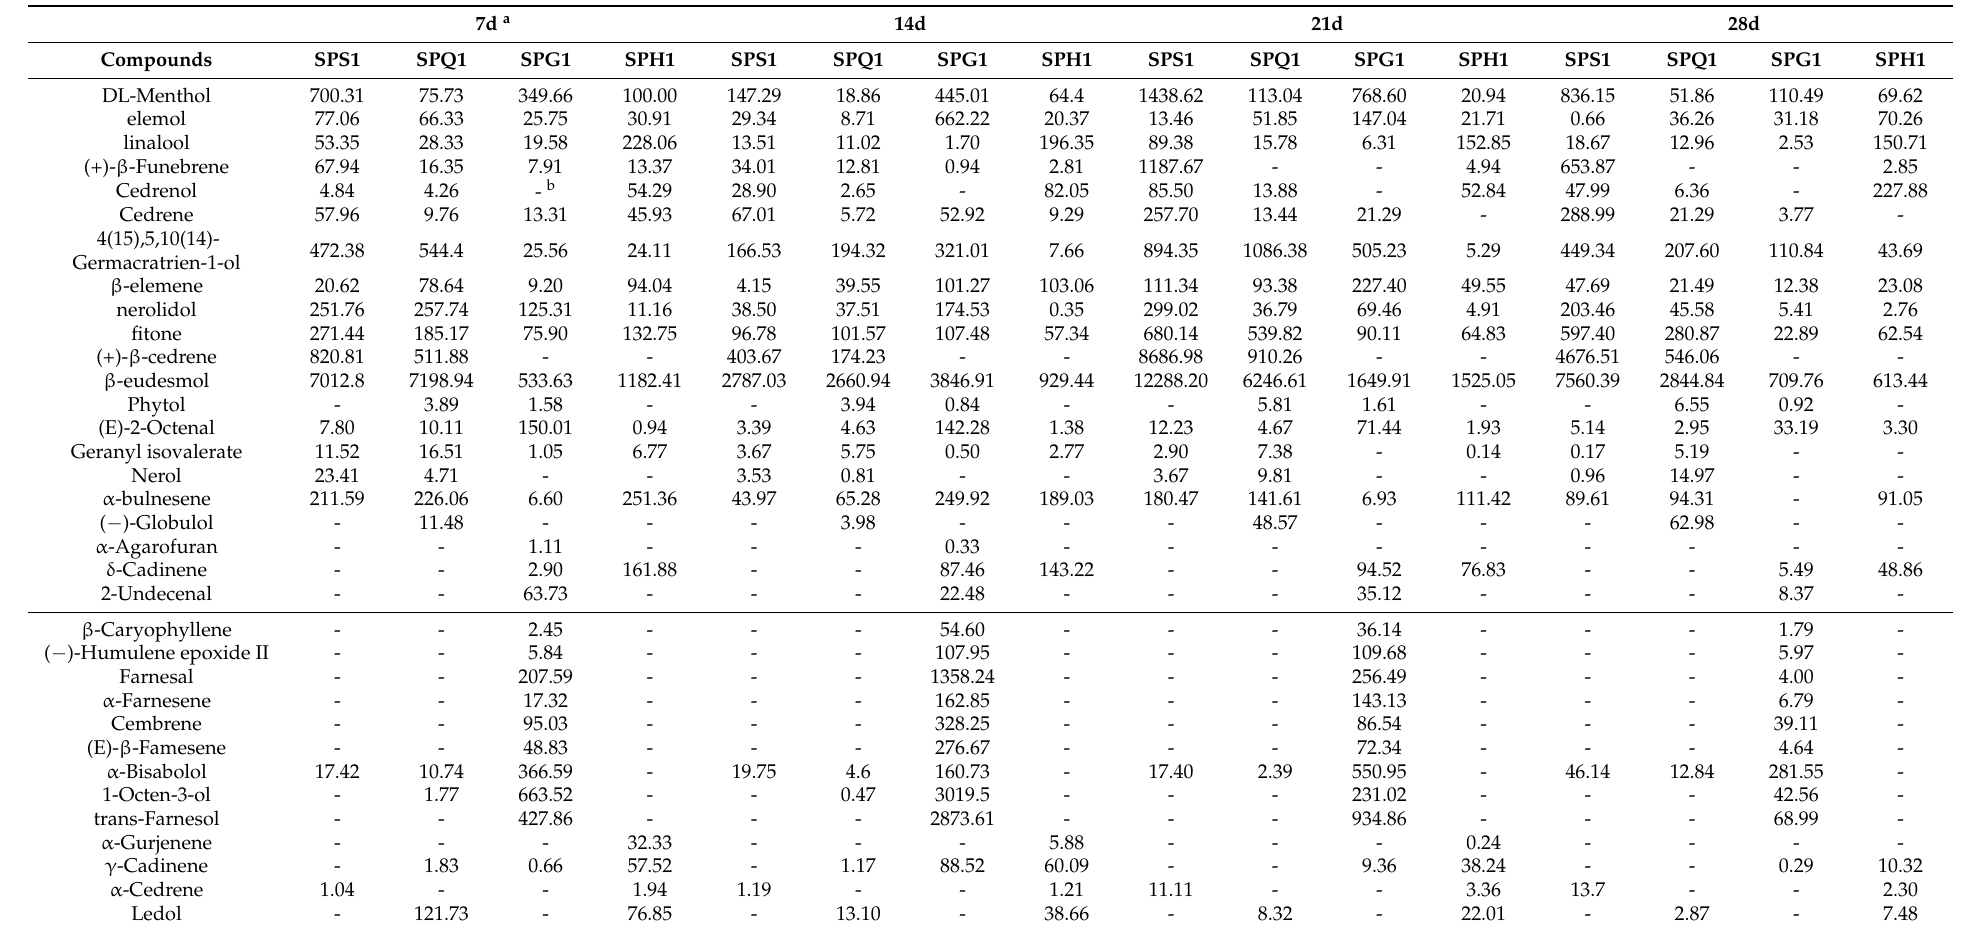
Table 4. Content ( µ g/kg) of terpenoids produced from different